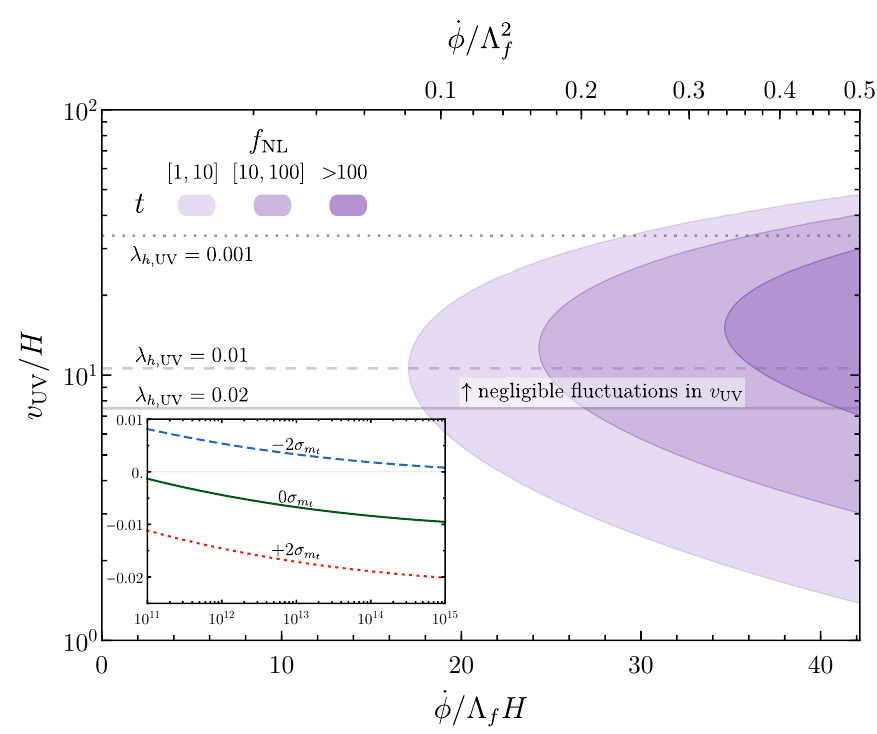
Figure 7 . The same plot as (cid:12)gure 6, specialized to the top quark, assuming that the Higgs potential is not signi(cid:12)cantly altered by the coupling of SM particles to the in(cid:13)aton. Above the dotted, dashed and solid gray lines, the Higgs (cid:13)uctuations are exponentially suppressed for Higgs quartics (cid:21) h; uv larger than the indicated value. The inset shows the running of the Higgs quartic (cid:21) h; uv as a function of the RG energy scale, and its dependence on the uncertainty of the measurement of the top quark mass at the LHC (see [53] for the reference values for m t ).). The green solid line corresponds the central value while the blue dashed and the red dotted lines show the (cid:6) 2 (cid:27)